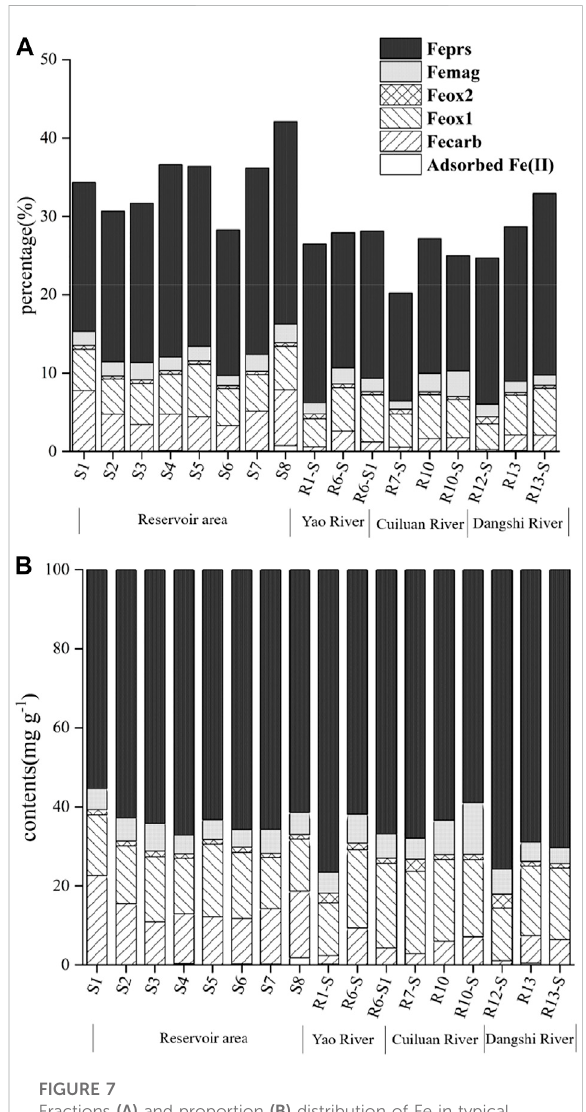
FIGURE 7 Fractions (A) and proportion (B) distribution of Fe in typical surface sediments and soils in the Xishan Reservoir drainage